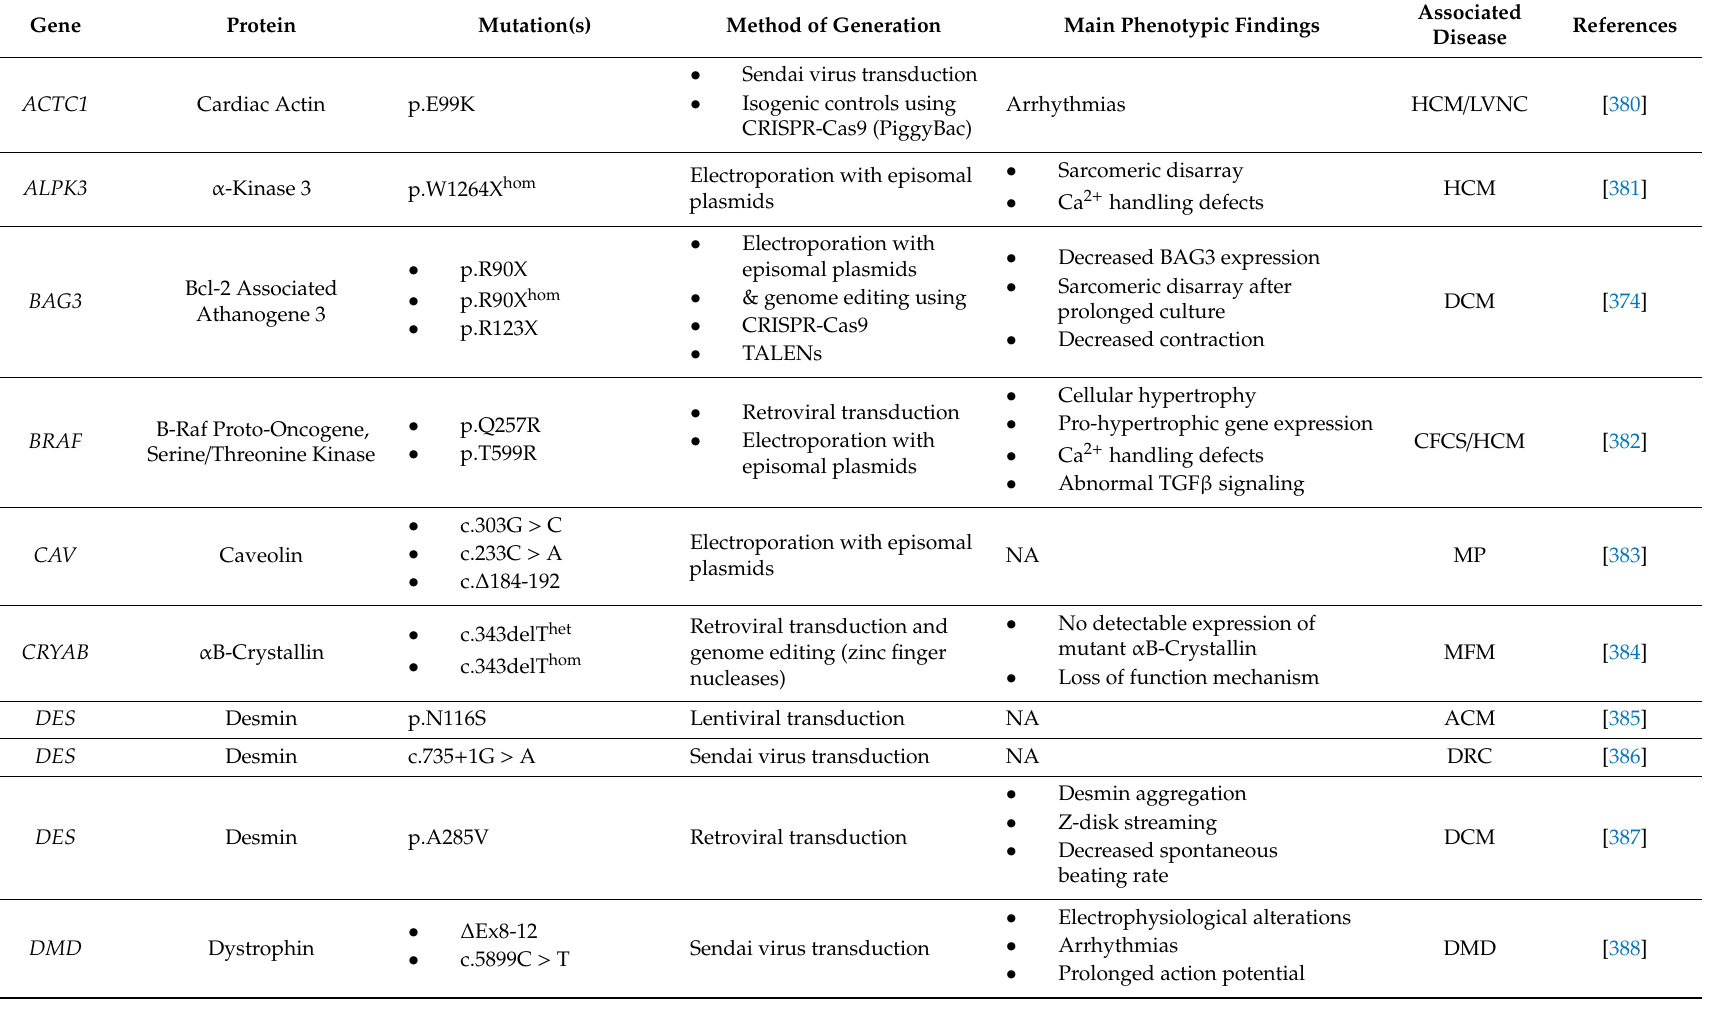
Table 2. Overview about important iPSC lines carrying mutations in genes associated with genetic cardiomyopathies or related diseases.